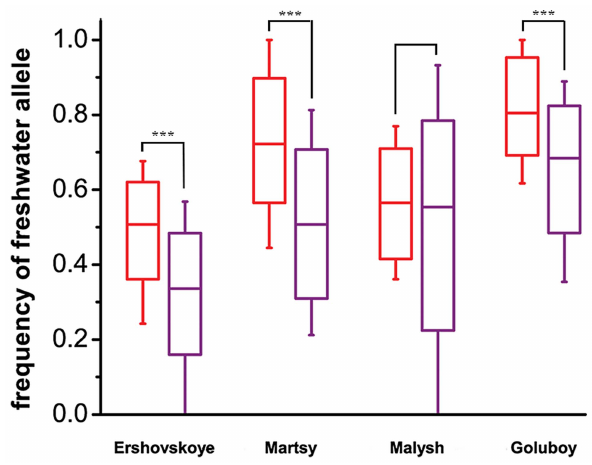
Figure 4. Comparison of mean frequencies of freshwater alleles at marker SNPs within and outside of identified DIs, at freshwater populations of different ages. Each two boxes correspond to the four young freshwater populations (anadromous from Lake Ershovskoye, Lake Martsy, Quarry Malysh, Quarry Goluboy). Statistical analysis was performed with two-tailed nonparametric Mann–Whitney U test. P values of , 0.001 are designated with three (***) asterisks. Dashes, boxes and whiskers correspond to the median, standard deviation, and 5 th and 95 th percentiles, respectively. Red, marker SNPs (under the strong criterion) located within clumps; purple, marker SNPs (under the strong criterion) located outside clumps.